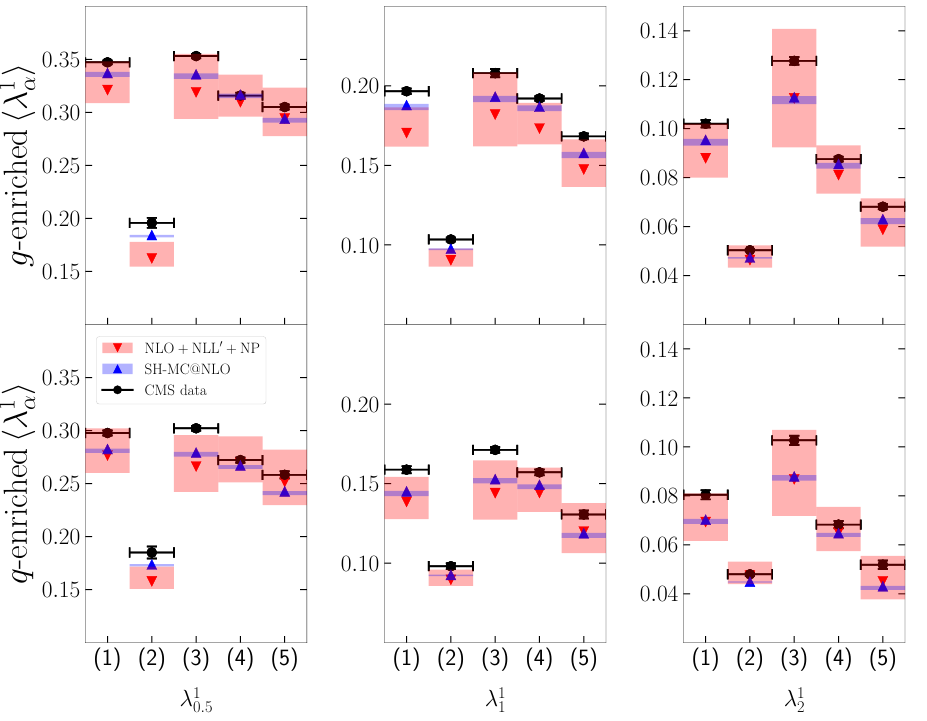
Figure 11. Jet-angularity mean values for the phase-space regions enriched with gluon- and quark jets in dijet and Z +jet production, respectively. See table 2 for details on the configurations and the respective process considered as g - and q